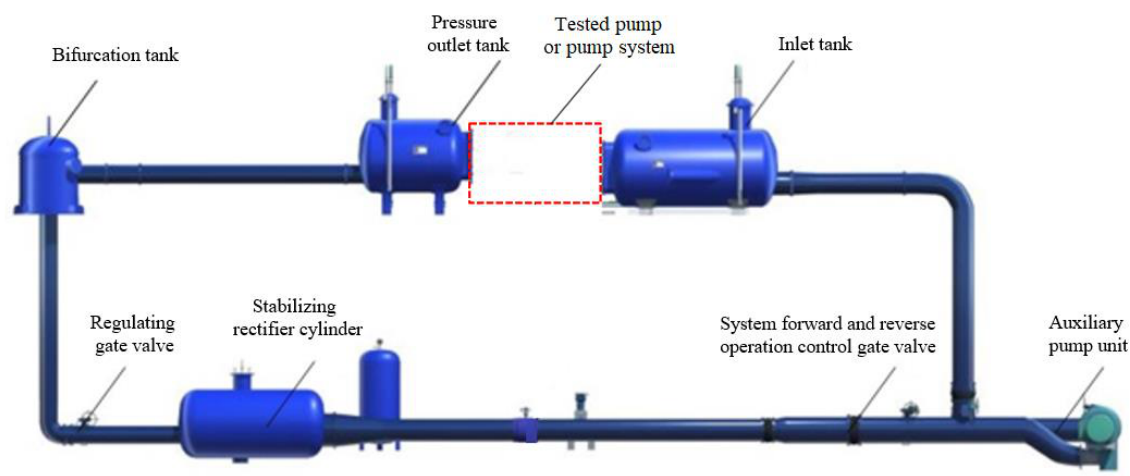
Figure 4. Schematic diagram of the high-precision hydro-mechanical test bench.